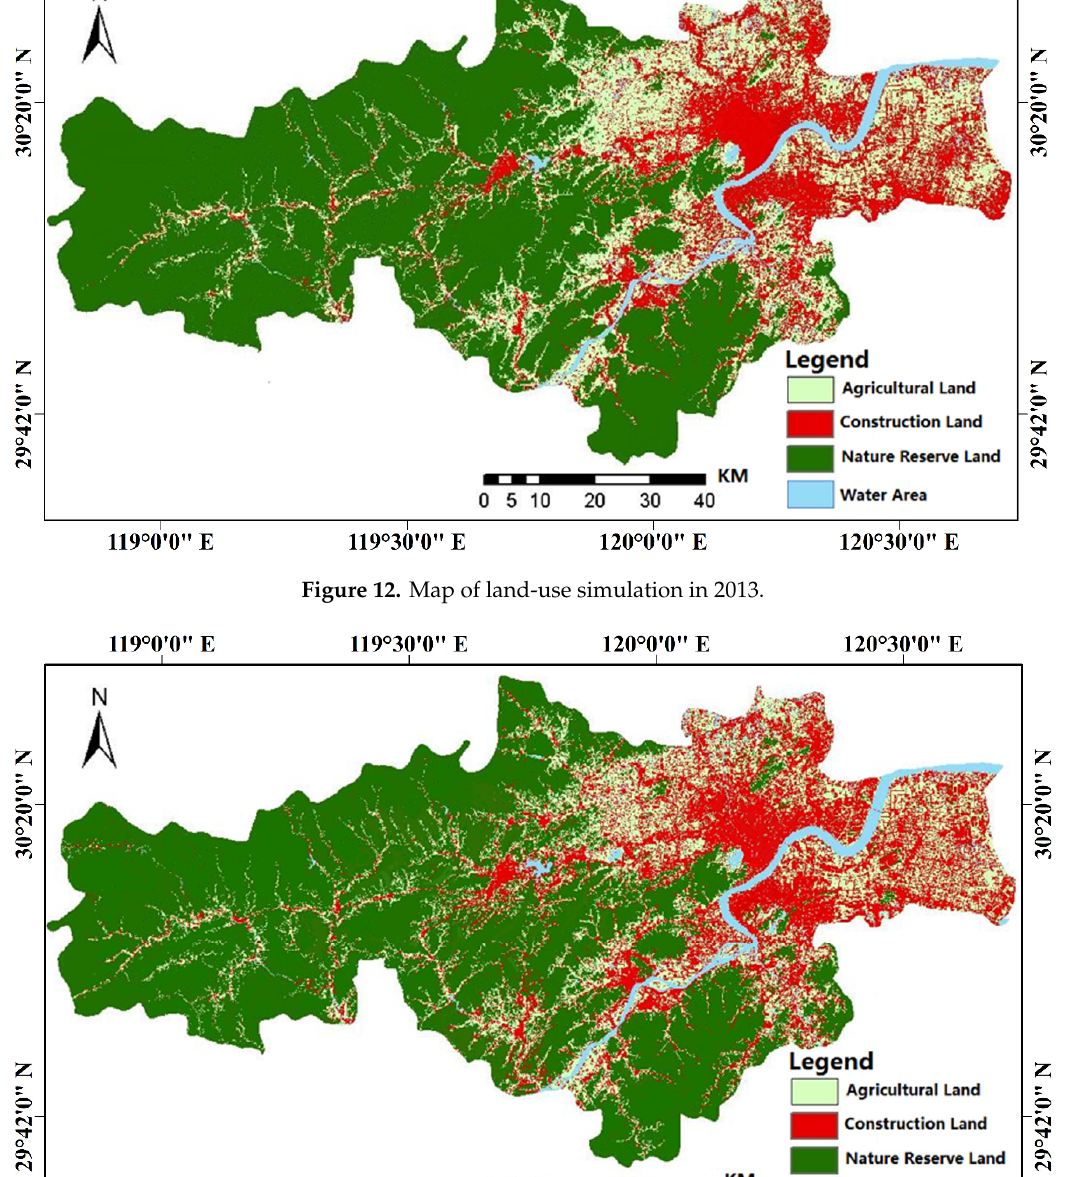
Table 6. The 2006–2013 transition-probability matrix (unit: %).